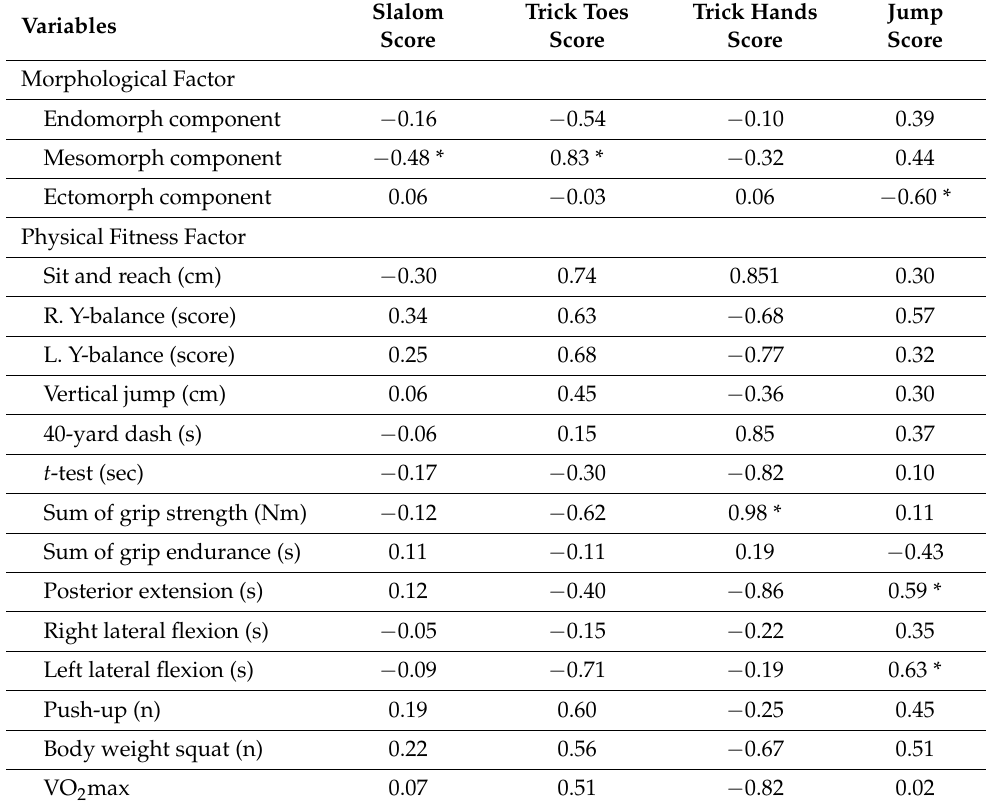
Slalom Trick Toes Trick Hands Jump Score Score Score Score